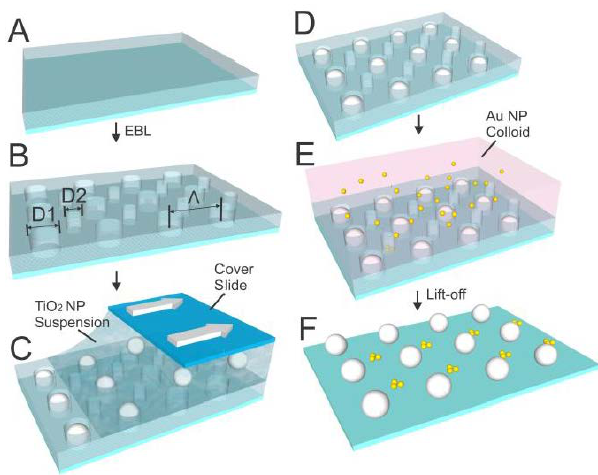
Figure 6: Scheme of template-guided self-assembly approach of the extended optoplasmonic arrays. (A) An array with two differ- ent binding sites of D1 and D2 is created on a PMMA film. (B) The separation between two identical binding sites is defined by the grating period, Λ . (C) Dispersing a suspension of TiO 2 nanoparticles that only bind to the larger binding site D1 creates (D), a dielectric nanoparticle array. (E) Smaller Au nanoparticles are then targeted to the vacant binding sites D2, generating the optoplasmonic array (F) after lift-off. Reprinted with permission from Hong et al. Adv.